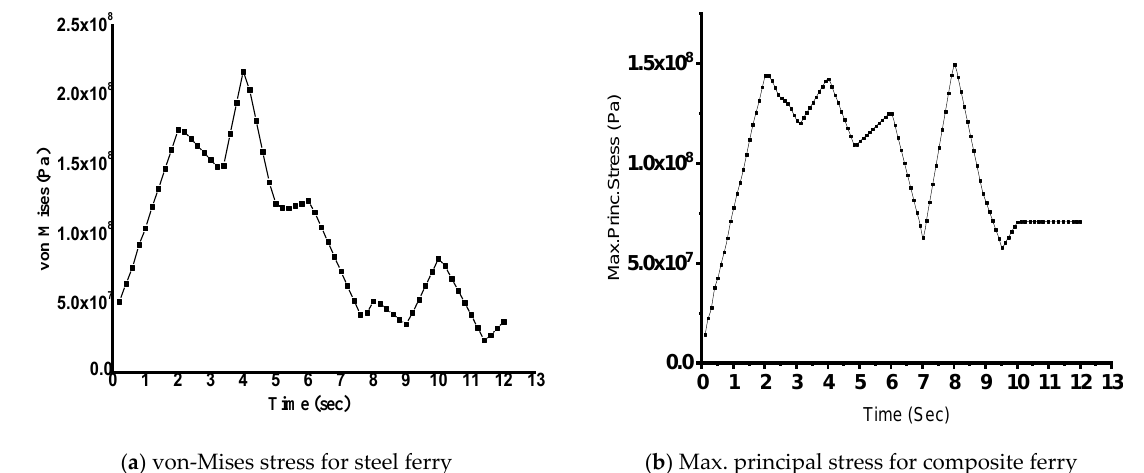
Figure 26. Stresses change with time for case 2.